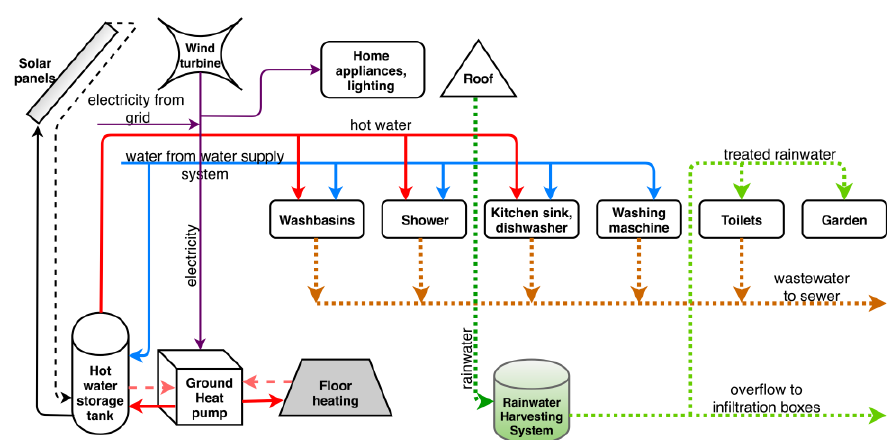
Figure 7. Diagram of system operation in Variant 4. Figure 8. Diagram of system operation in Variant 5.